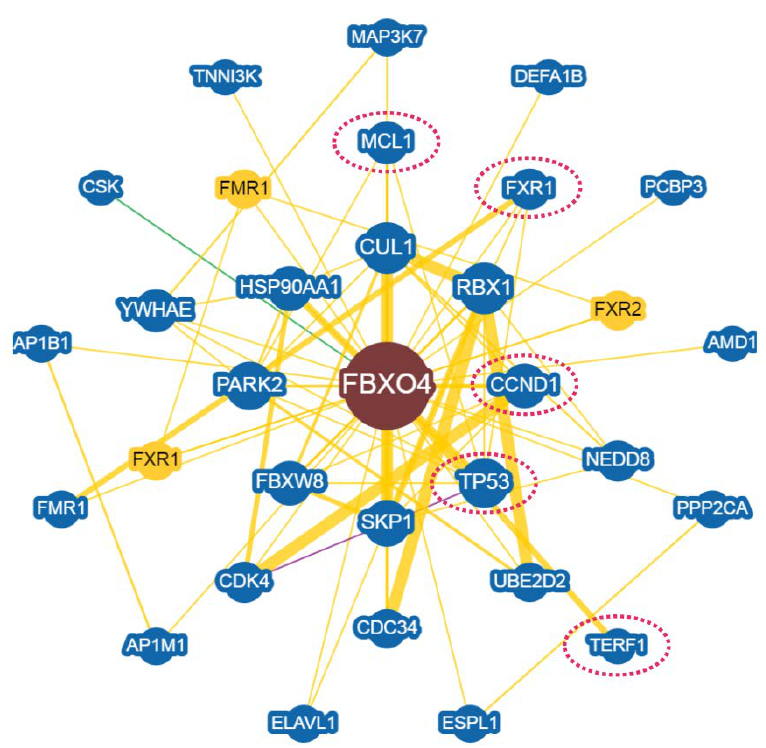
Figure 4. The BioGRID analysis suggests potential substrates of Fbxo4 (https://thebiogrid.org/ (accessed on 22 January 2022)). Yellow lines, Association with Physical Evidence; Green lines, Association with Genetic Evidence; Purple lines, Association with Genetic and Physical Evidence. Pink circle indicates the existence of biochemical data to support they are Fbxo4